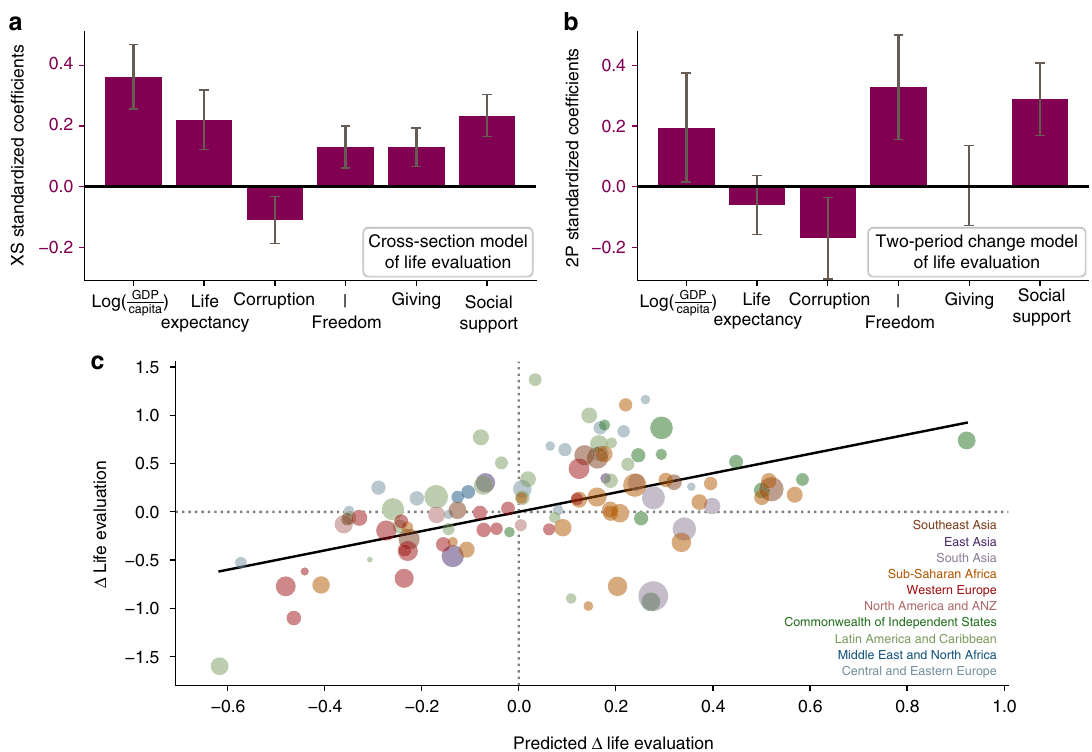
Fig. 1 Predictions of life evaluations from proxy variables. a Six predictor variables are used simultaneously to predict life evaluations in static cross-section between countries (XS). All corresponding country-year observations are used, after removing global year-to-year changes. Effect sizes are shown, with 90% con fi dence intervals, normalized to standard deviations, in order to compare the estimated coef fi cients across predictor variables. The strongest predictor is the income variable, but all predictors have signi fi cant strength, and their con fi dence intervals largely overlap. b As in a but for the dynamic, two-period model (2P) which explains changes over time within countries. In the 2P model, con fi dence intervals are looser, and the income coef fi cient excludes zero with only ~90% con fi dence intervals. However, models for annual changes (see Supplementary Information) show similar patterns and have tighter con fi dence intervals. c The relationship between observed and predicted changes in life evaluation using the 2P model. The changes are the differences in national average life evaluations between 2005 – 2007 and 2014 – 2016. Symbol size corresponds to the population size of each country